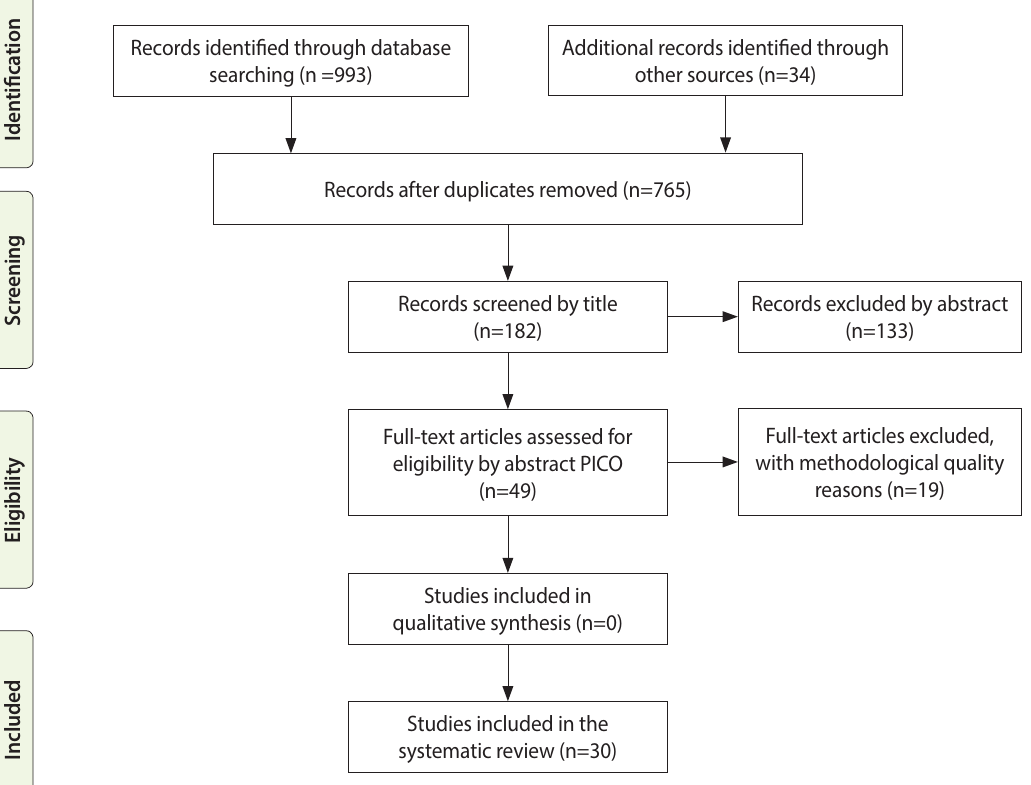
Figure 1. PRISMA (Preferred Reporting Items for Systematic Reviews and Meta-Analysis) flow diagram of the selection of studies for the systematic review and meta-analysis of associations of antiretroviral therapy with congenital anomalies. PICO, population, intervention, comparator,